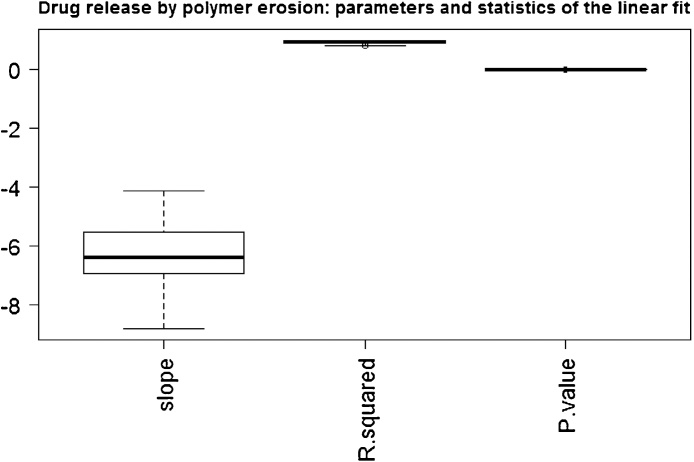
Slope, R-squared and p-value of the F statistic of the linear fit for N(t) given by Eq. (5) obtained in 50 simulation runs.